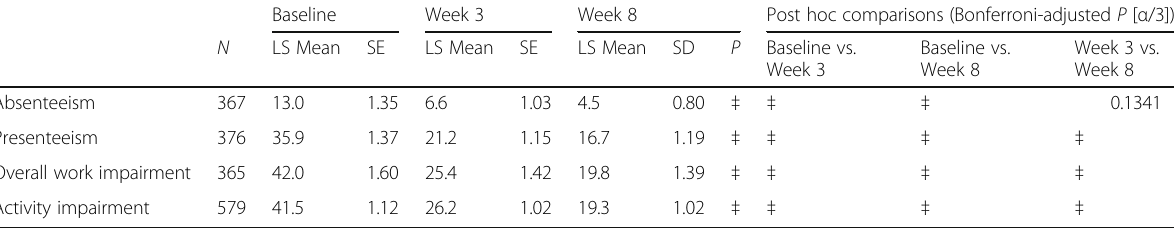
Table 3 WPAI:UC scores for the acute phase sample at acute phase visits Baseline